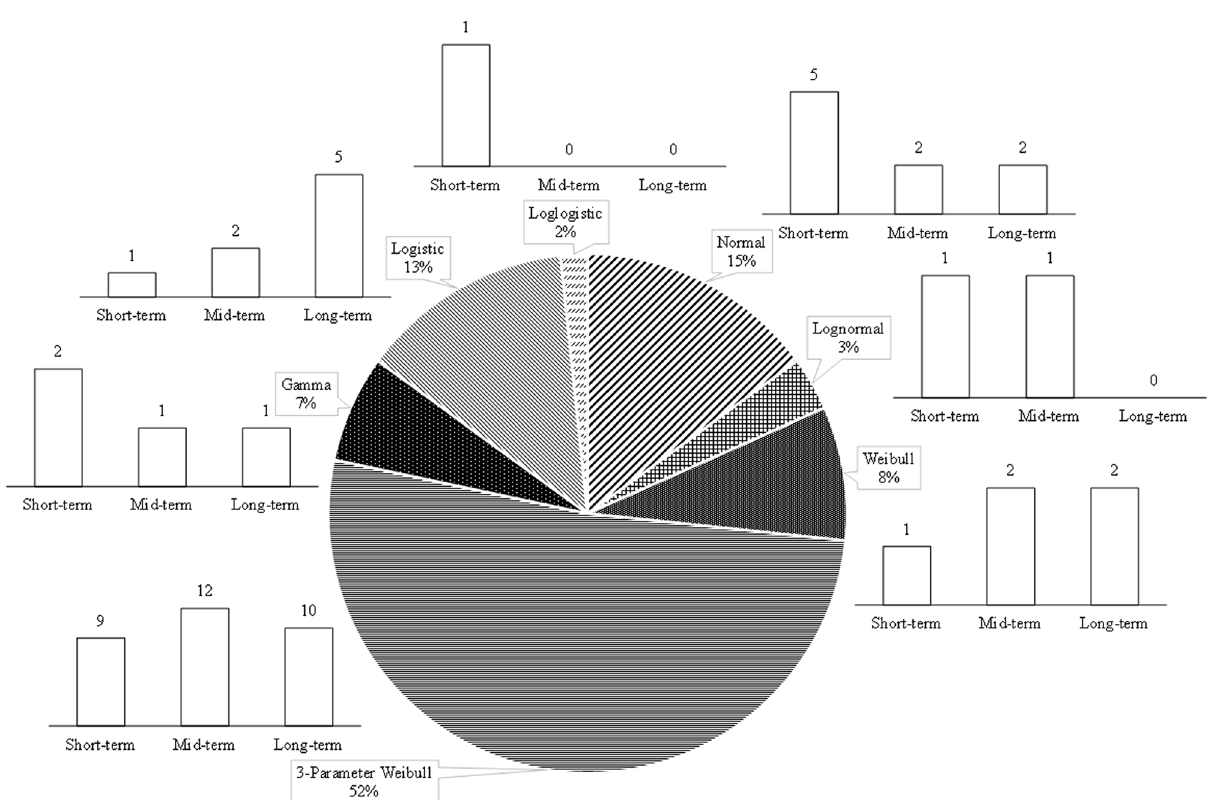
Figure 5. The frequency of using different theoretical distributions as posterior pdf